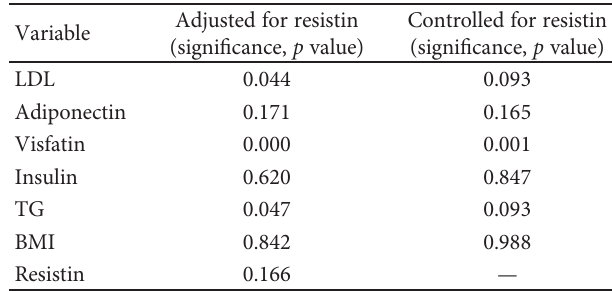
Table 2: Serum leptin levels in diabetic males (multiple regression model adjusted and controlled for